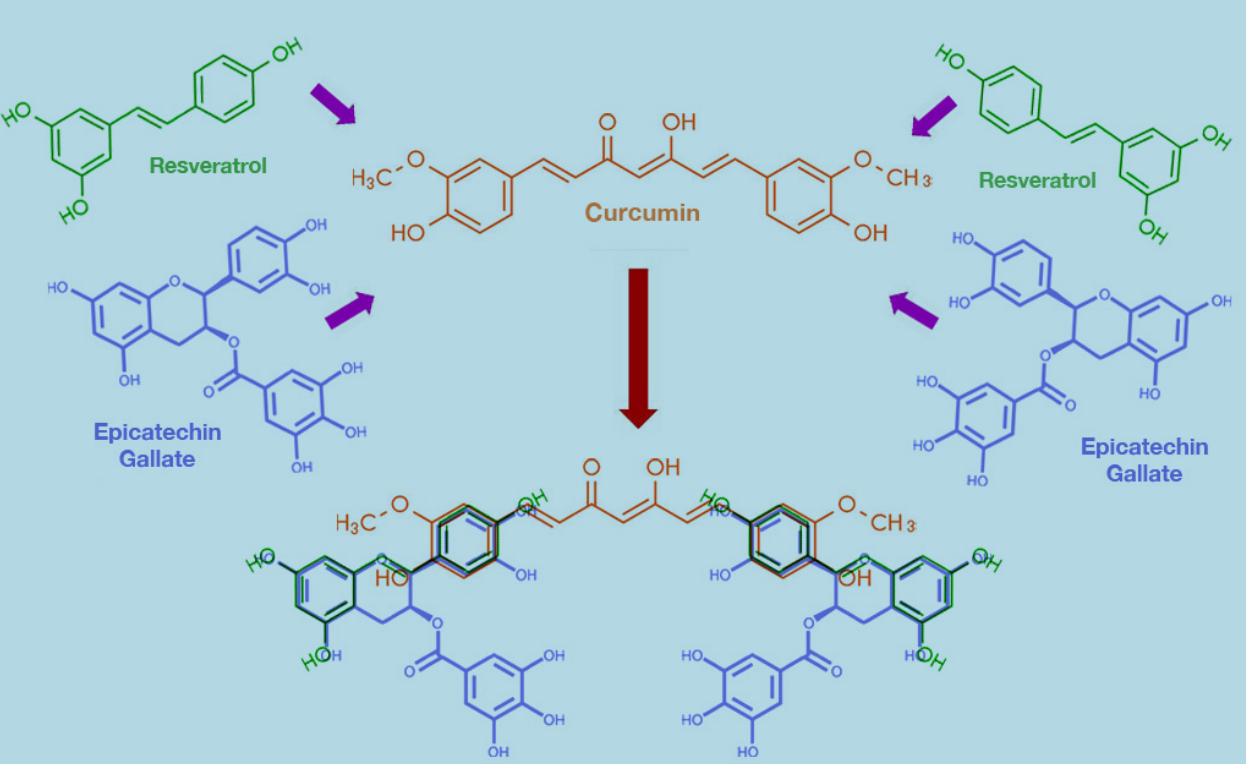
Figure 4. Proposed pi-complex formation among the polyphenols curcumin, resveratrol, and epicatechin gallate in Tricurin due to hydrophobic association in water.